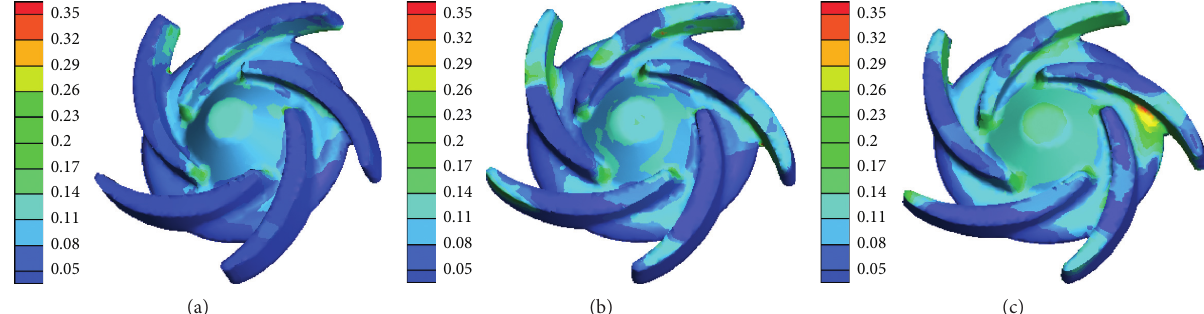
Figure 7: Cloud diagram of solid-phase volume distribution of impeller with different particle sizes ( C (c) 0.2mm.